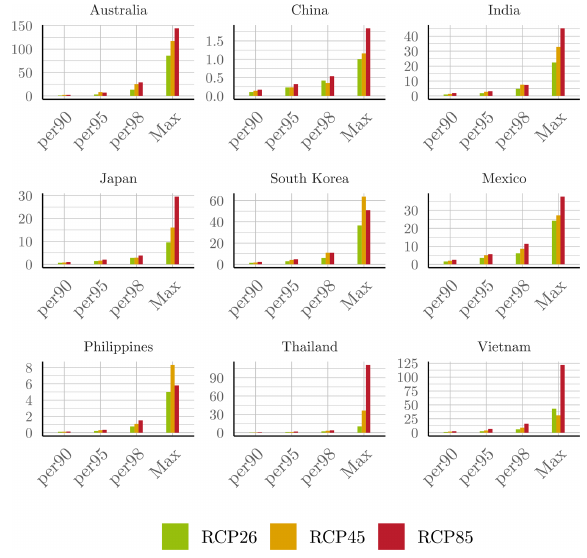
Figure 27. Damage cost channeled to excess spread (cost of debt) of different countries, measured in basis points (one basis point =